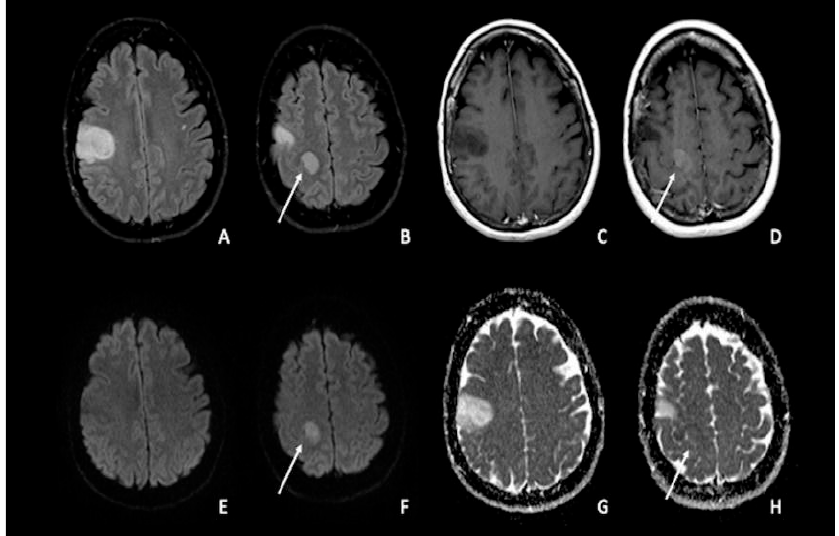
Figure 1. Double site of glioma infiltration in the right Rolandic frontal region: ( A , B ) Both lesions present similar hyperintensity on FLAIR images. The most cranial lesion (arrow) showed slight post-contrastographic enhancement ( D ) and restricted water diffusion on DWI ( F ), characterized by slightly low values on ADC map ( H ); this condition could be linked to an anaplastic aspect of the tumor, with restricted diffusion explained by an increase in tumor cellularity. The most caudal lesion did not show contrast enhancement, with a marked hypointense signal on post-contrastographic T1-weighted image ( C ); the same lesion presented no restricted diffusion with increased ADC values ( E – G ). FLAIR = fluid-attenuated inversion recovery; DWI = diffusion-weighted imaging; ADC: apparent diffusion